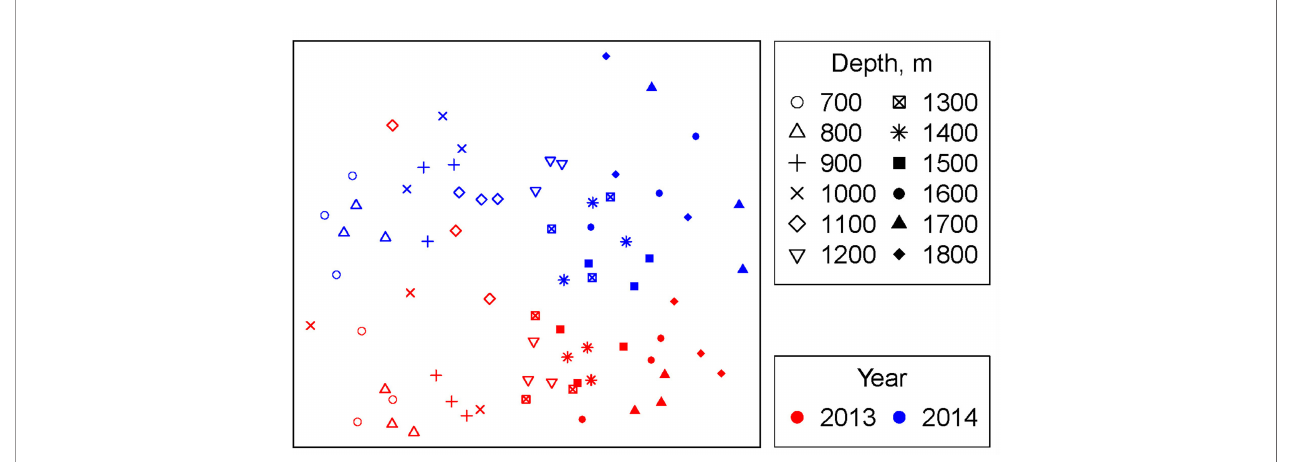
FIGURE 7 | Non-metric multidimensional scaling ordination. MDS stress =